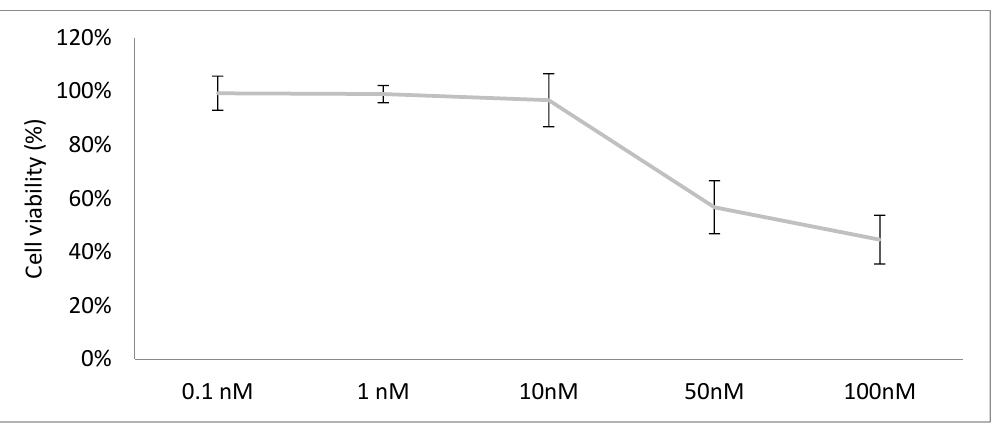
Figure 5. Cell viability (%) of PC-3 when exposed to Empty-Li-2.